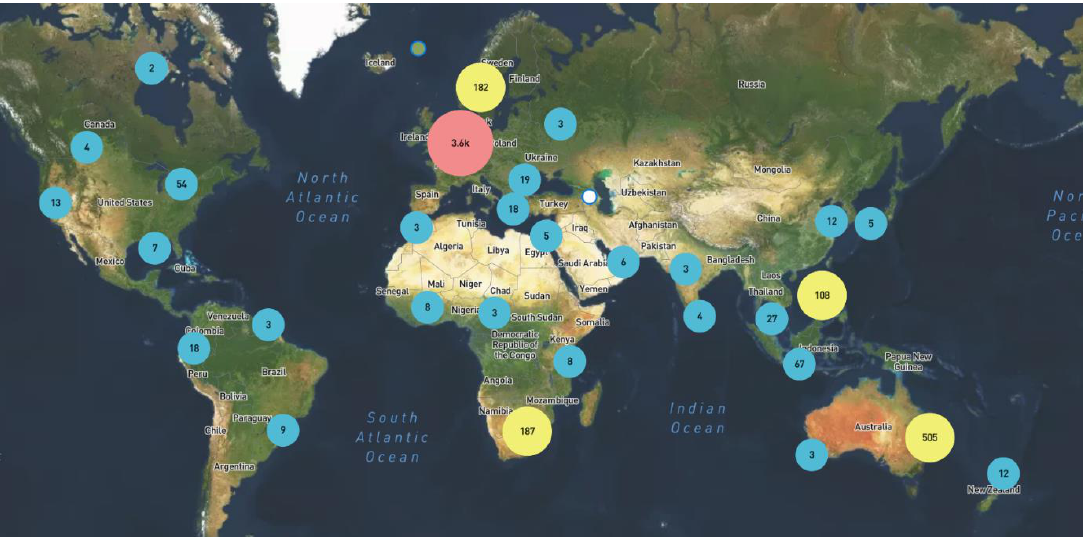
Figure 1. Geographical distribution of ClimateScan datapoints (source: climatescan.org).